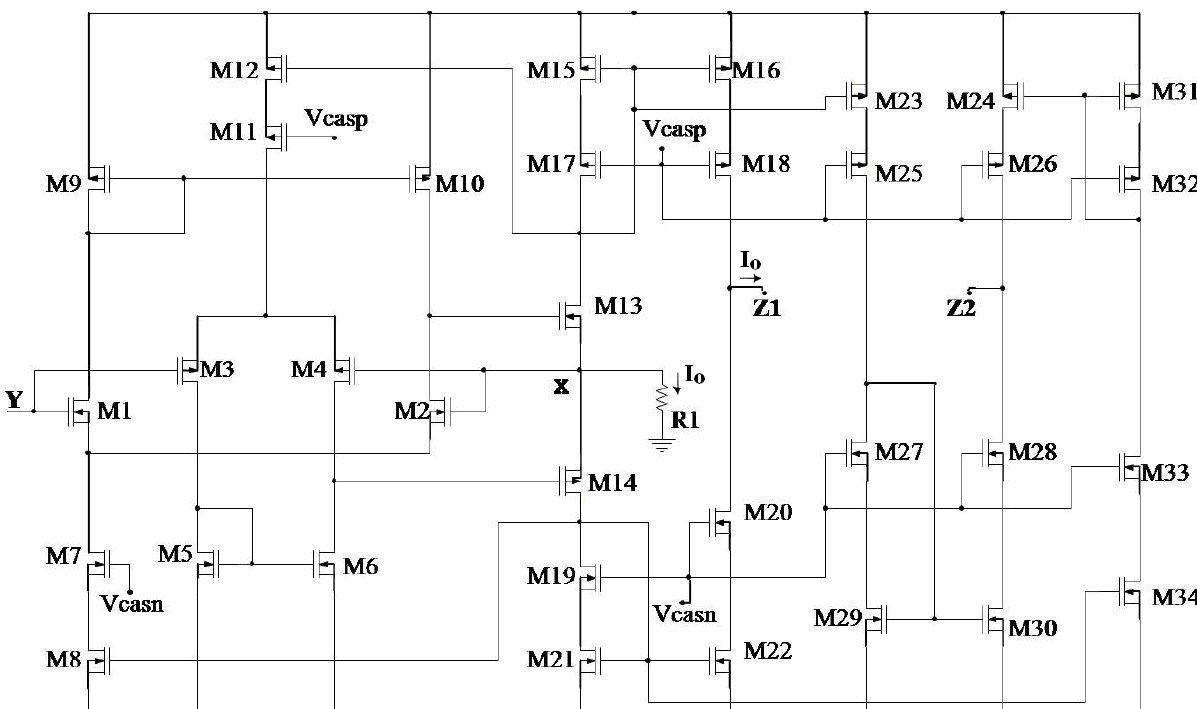
Fig.4: Schematic diagram of the Current Conveyor current